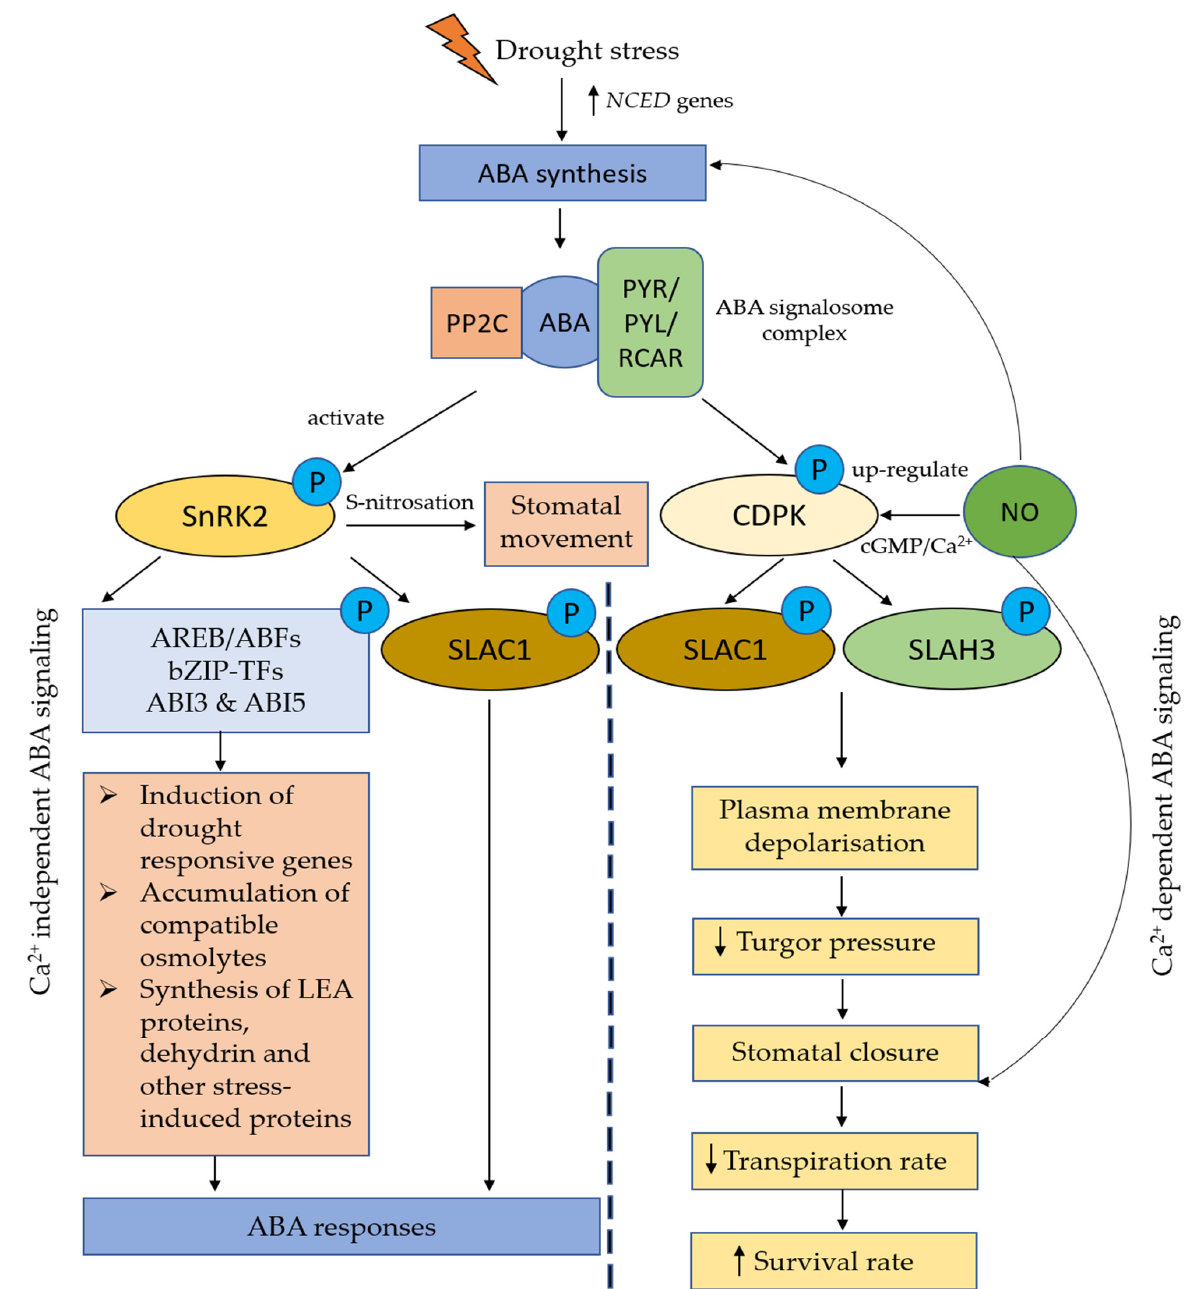
Figure 4. Schematic diagram showing crosstalk between abscisic acid (ABA) and nitric oxide (NO) under drought stress. Drought stress activates the regulation of 9-cis-epoxycarotenoid dioxygenase ( NCED ) gene to enhance biosynthesis of ABA at leaf vascular parenchyma cells, which are the primary sites for ABA biosynthesis. ABA molecule binds to the pyrabactin resistance1/PYR1-like/regulatory components of ABA (PYR/PYL/RCAR) receptors and protein phosphatase 2C (PPC2) to form ABA signalosome complexes. These ABA signalosome complexes phosphorylate either (I) sucrose nonfermenting 1 (SNF1)-related protein kinase 2 (SnRK2) in Ca 2+ independent ABA signaling pathway or (II) calcium-dependent protein kinase (CDPK) in Ca 2+ dependent ABA signaling. In Ca 2+ independent ABA signaling pathway, SnRK2 proteins phosphorylated AREB/ABF, b-ZIP, ABI3, and ABI5 transcription factors to induce expression of drought-responsive genes, accumulation of compatible osmolytes, as well as synthesis of LEA proteins, dehydrin, and other stress-induced proteins or ion channels (e.g., SLAC1), and subsequently trigger ABA responses. In Ca 2+ dependent ABA signaling pathway, CDPKs are activated by NO. The increase of Ca 2+ and phosphorylated ion channels [SLAC1 and S-type anion channel 3 (SLAH3)] trigger a cascade of ABA responses. These include plasma membrane depolarization, decrease of turgor pressure, stomatal closure, and reduction of transpiration rate.